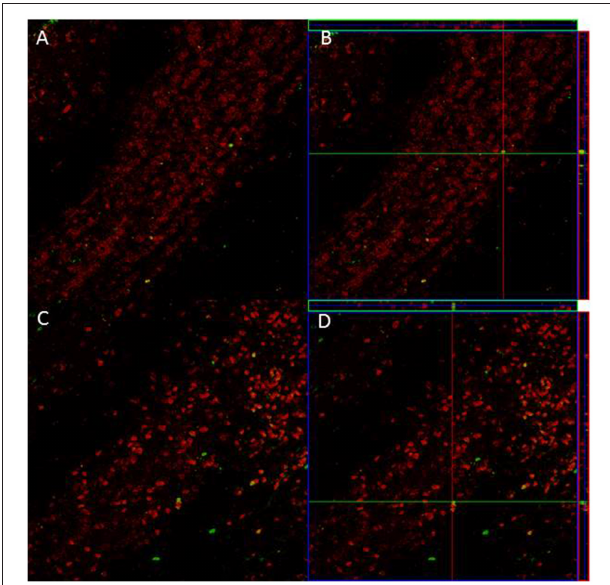
FIGURE 3 | Confocal images of cells in the GrL of the AOB, double-labeled with NeuN (red) and BrdU (green) in control (A) and 3E group (C). Projection and orthogonal plane in control (B) and 3E group (D)